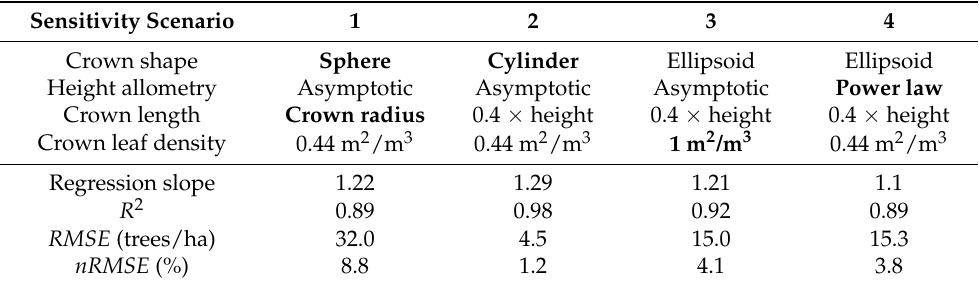
Table 2. Sensitivity analysis of different model assumptions (see also Figure A2). The changed model assumptions for each scenario are written in